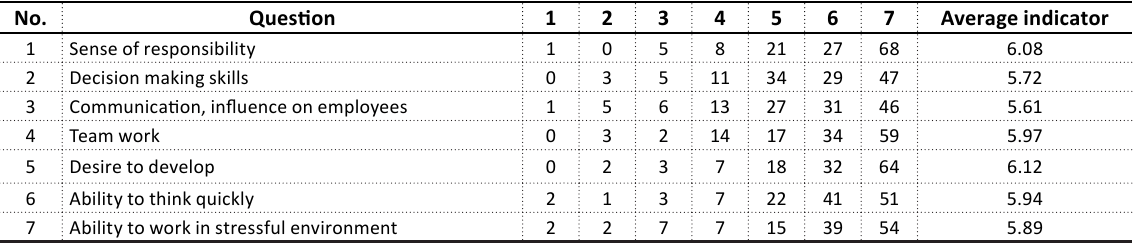
Source: Result of our research.